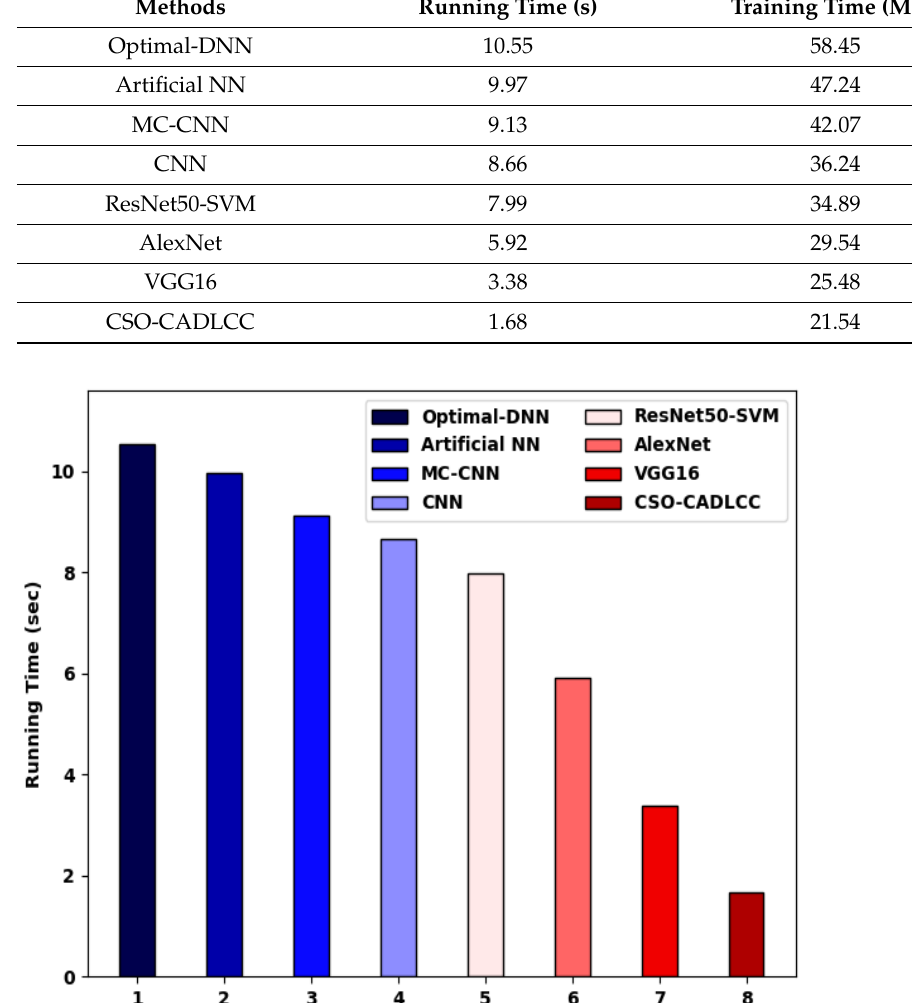
Figure 10. RT analysis results of the CSO-CADLCC approach with recent